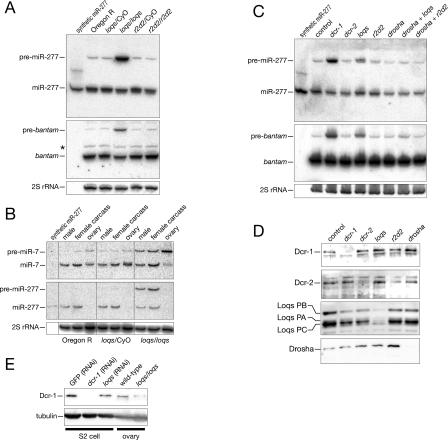
Loss of Loqs Function Increases the Steady-State Concentration of Pre-miRNA(A) Northern analysis of total RNA from wild-type, loqs
f00791 heterozygotes and homozygotes, and r2d2 heterozygotes and homozygotes for whole males, probed for miR-277 and bantam. The membrane was first hybridized with the miR-277 probe, stripped and probed for 2S rRNA as a loading control, then stripped again and probed for bantam miRNA. Asterisk: the 2S probe was not completely removed before the hybridization with the bantam probe, resulting in an additional band above the mature bantam RNA.(B) Total RNA from whole males, female carcasses remaining after ovary dissection, and dissected ovaries was probed for miR-7. As a control for successful dissection, the blot was also probed for miR-277, which is not expressed in ovaries (KF and PDZ, unpublished results). 2S rRNA again served as a loading control.(C) Depletion of dcr-1 or loqs in S2 cells by RNAi leads to pre-miRNA accumulation. Total RNA was isolated after dsRNA-triggered RNAi of the indicated genes. The control sample was treated with dsRNA corresponding to the polylinker sequence of pLitmus28i.(D) Depletion of Dcr-1, Dcr-2, Loqs, and Drosha was confirmed by Western blotting.(E) Western blotting analysis demonstrates that Dcr-1 levels are not significantly reduced by depletion of Loqs by RNAi in S2 cells, but are lower in loqs
f00791 mutant ovaries.